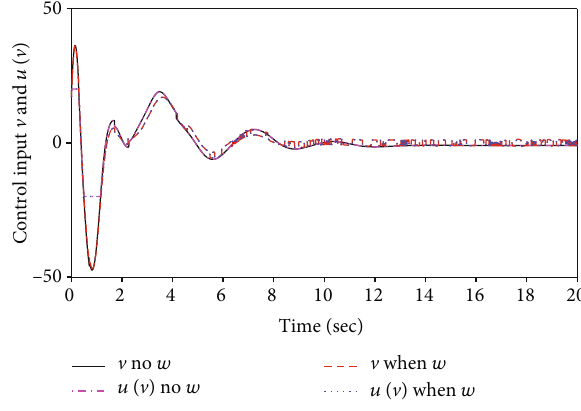
Figure 12: Control